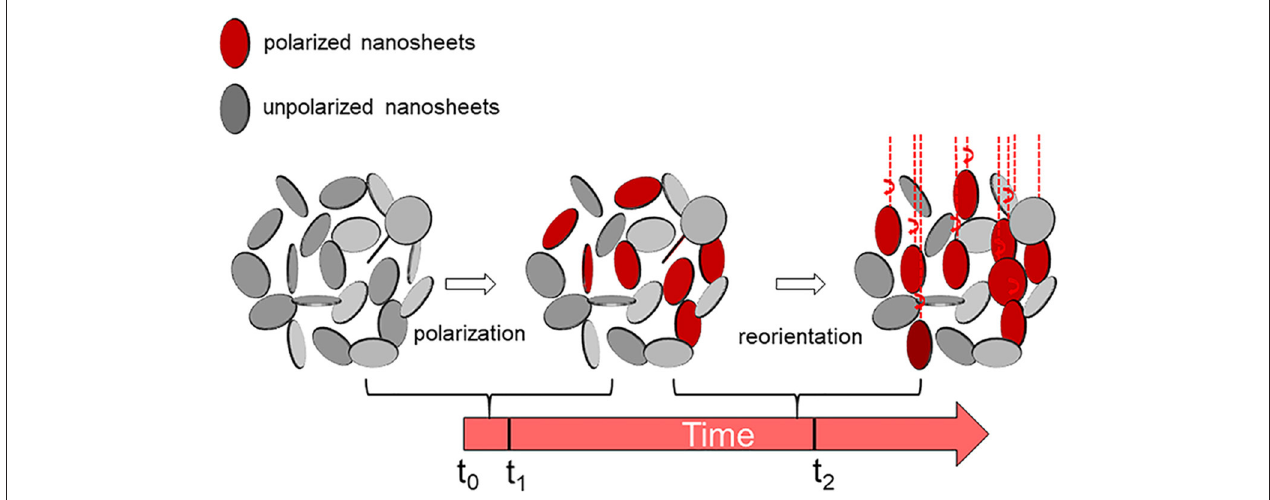
FIGURE 4 | Schematic illustration of the time required for the diffraction ring formation. The time can be divided into two parts. The t 0 indicates the laser start to incident on the medium. The polarization of 2D nanosheets finished in t 0 -t 1 region. The reorientation of 2D Nb 2 C occurs in t 1 -t 2 time zone. t 0 -t 2 time zone represents the time of the diffraction ring formation. t 2 diffraction rings become maximum.